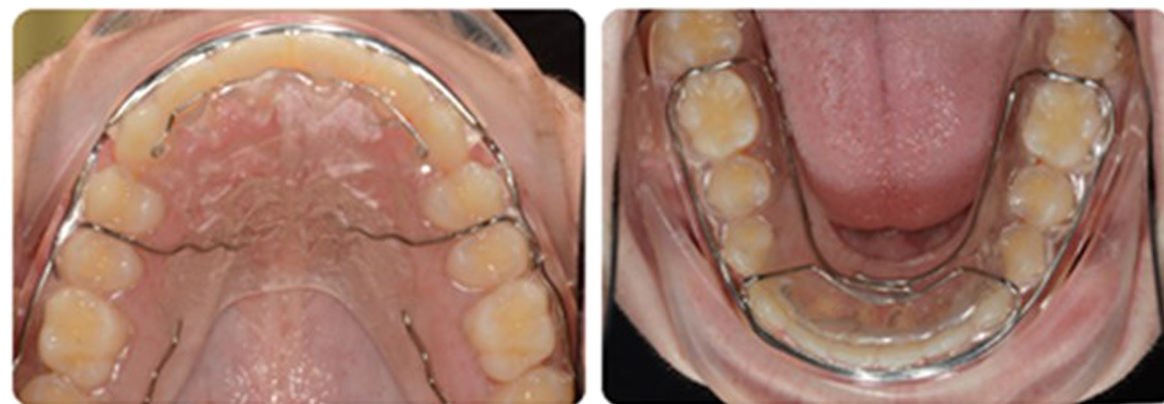
Figure 10. Dohner retainers.